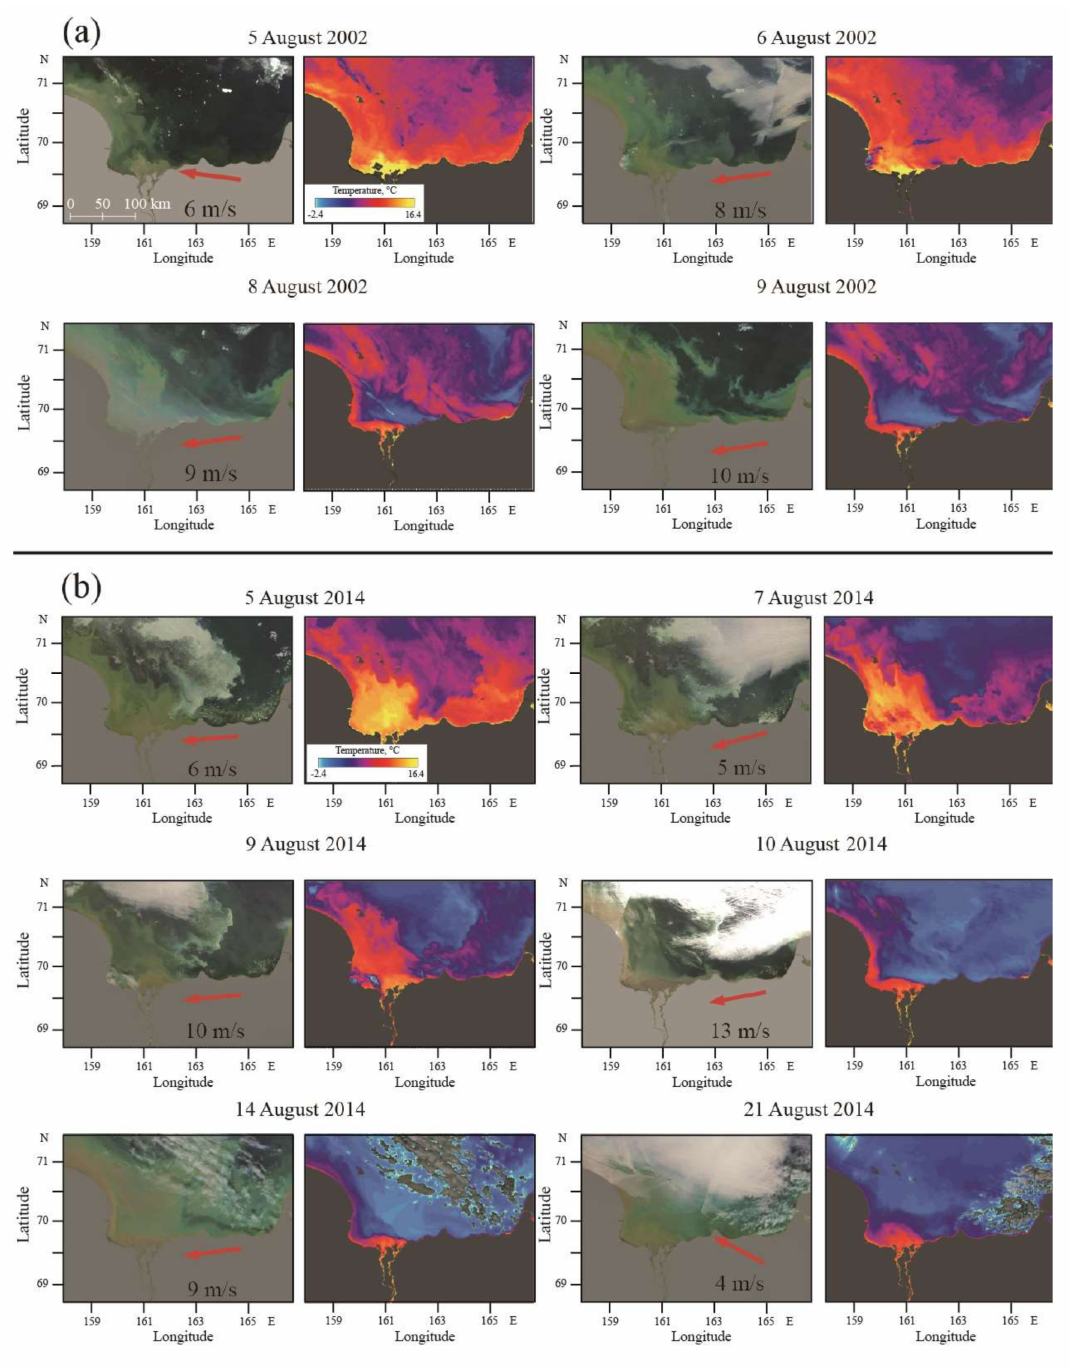
Figure 10. Corrected reflectance (left) and brightness temperature (right) from MODIS Terra and MODIS Aqua satellite images of the area adjacent to the Kolyma Delta acquired on ( a ) 5, 6, 8, 9 August 2002 and ( b ) 5, 7, 9, 10, 14, 21 August 2014 illustrating formation and dissipation of upwelling events in response to wind forcing